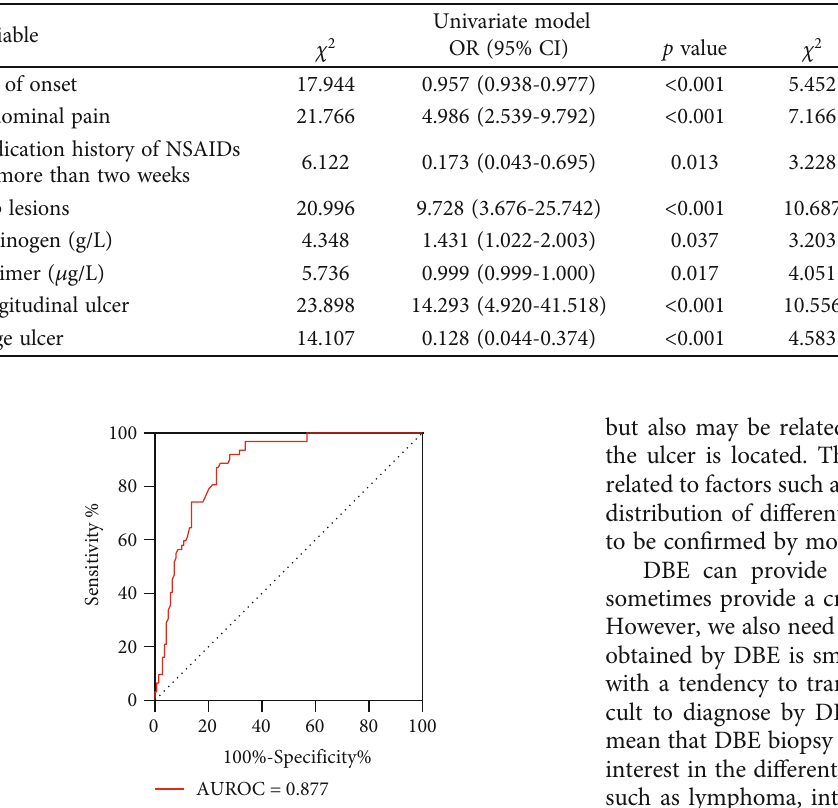
Table 7: Univariate and multivariate binary logistic regression for ISBCD.